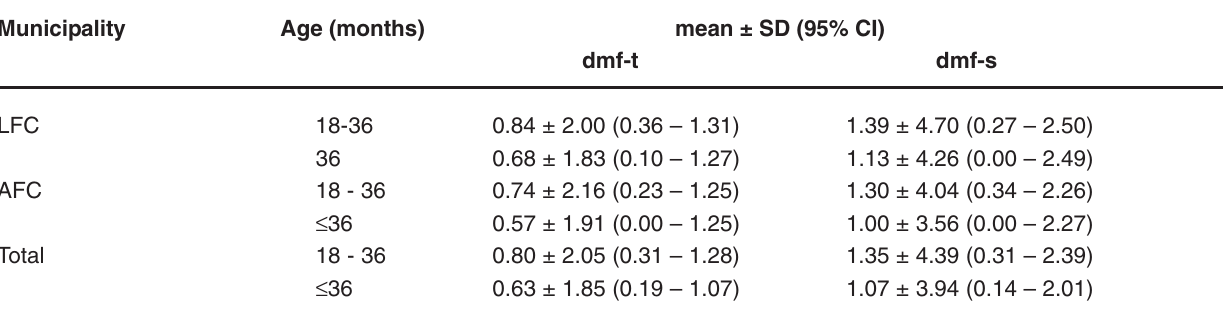
AFC = with adequate fluoride content; LFC = with low fluoride